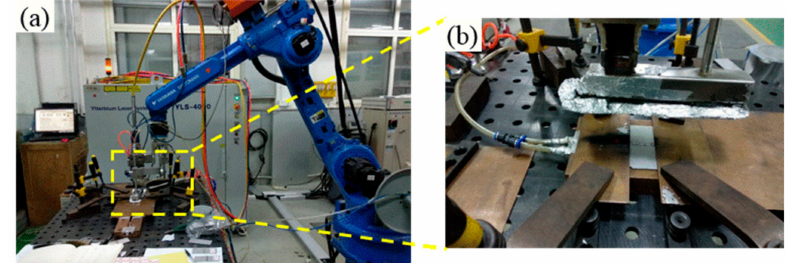
Figure 1. ( a ) Robot-based laser welding system, and ( b ) clamping device.